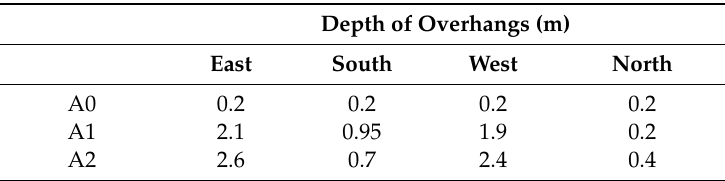
Table 3. Results with implemented cooling, heating and lighting control.